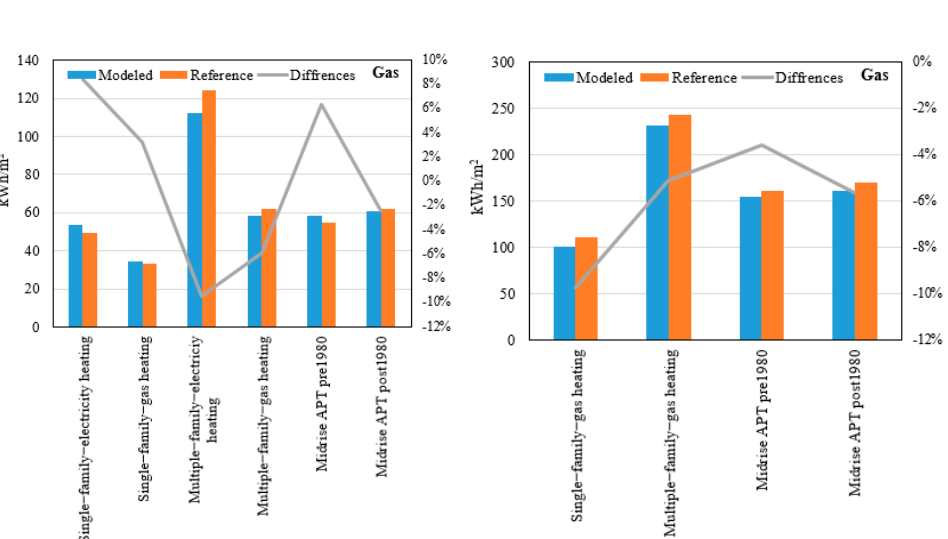
Figure 6. Comparison of the modeled and referenced energy-use intensity for residential and commercial